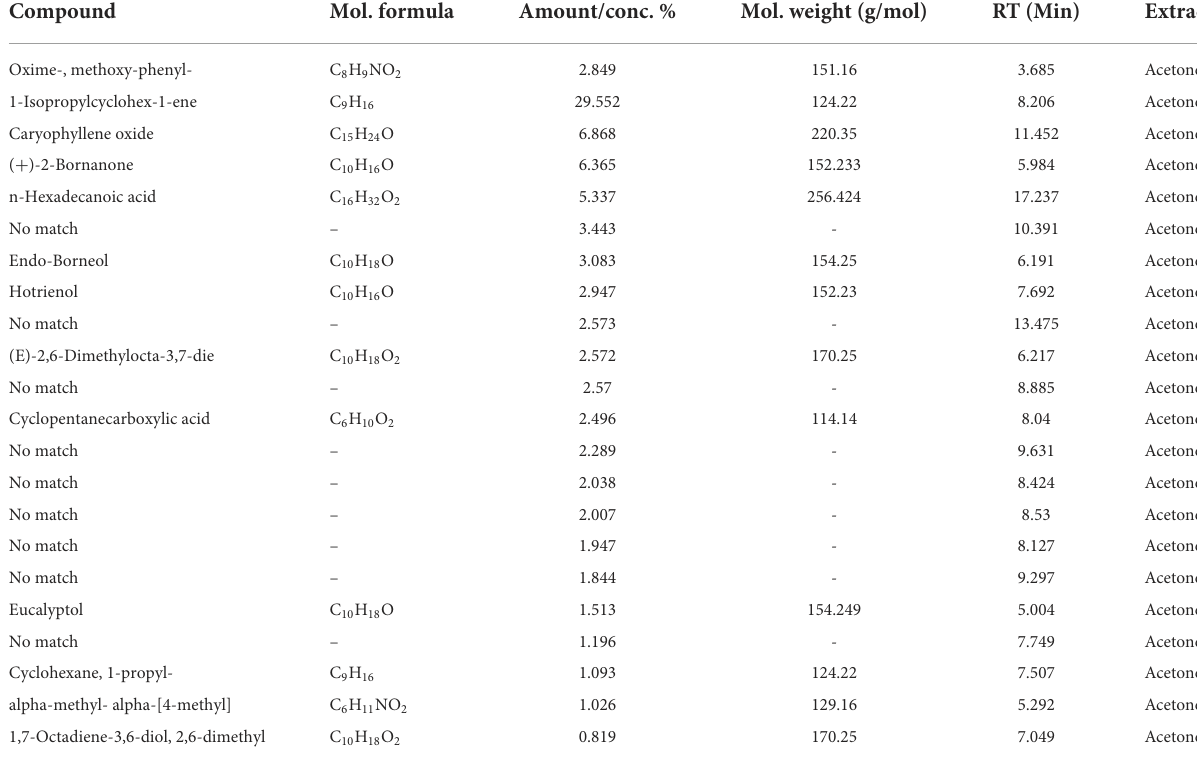
TABLE 5 GC/MS analysis of an acetone-based extract of N. cataria using NIST 17 Library showed (12 identified phytochemicals + 9 unmatched) chemicals, arranged according to concentration present. Compound Mol. formula Amount/conc. % Mol. weight (g/mol) RT (Min) Extract